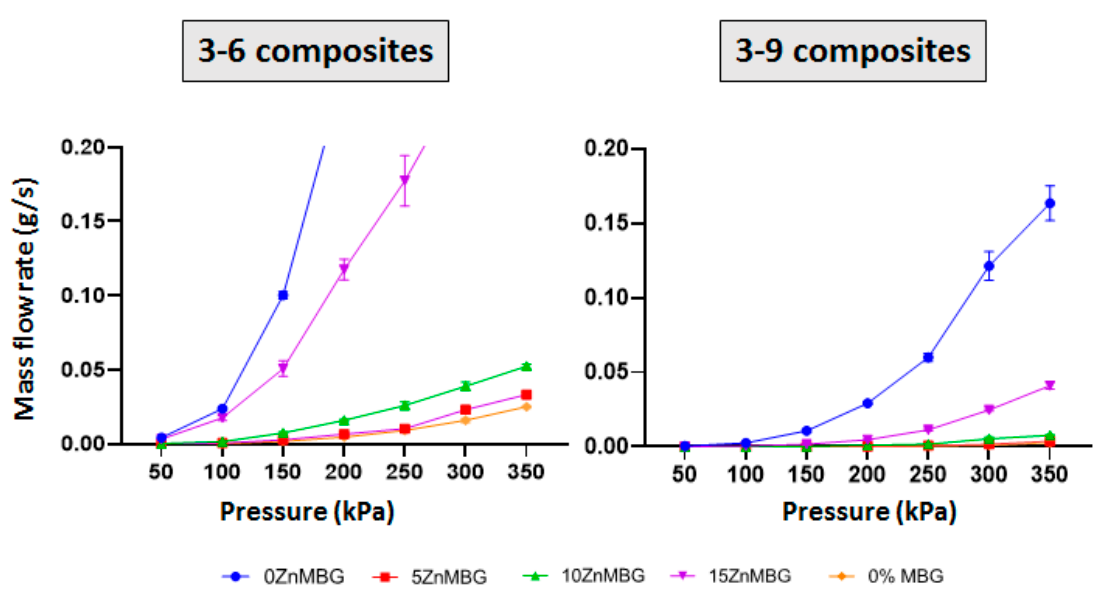
Figure 3. Mass flow analysis of 3–6 and 3–9 composite inks containing 7% of each ZnMBG as well as control inks without MBG at increasing pressures from 50 up to 350 kPa. Values on the plots are means ± SD, n = 3.